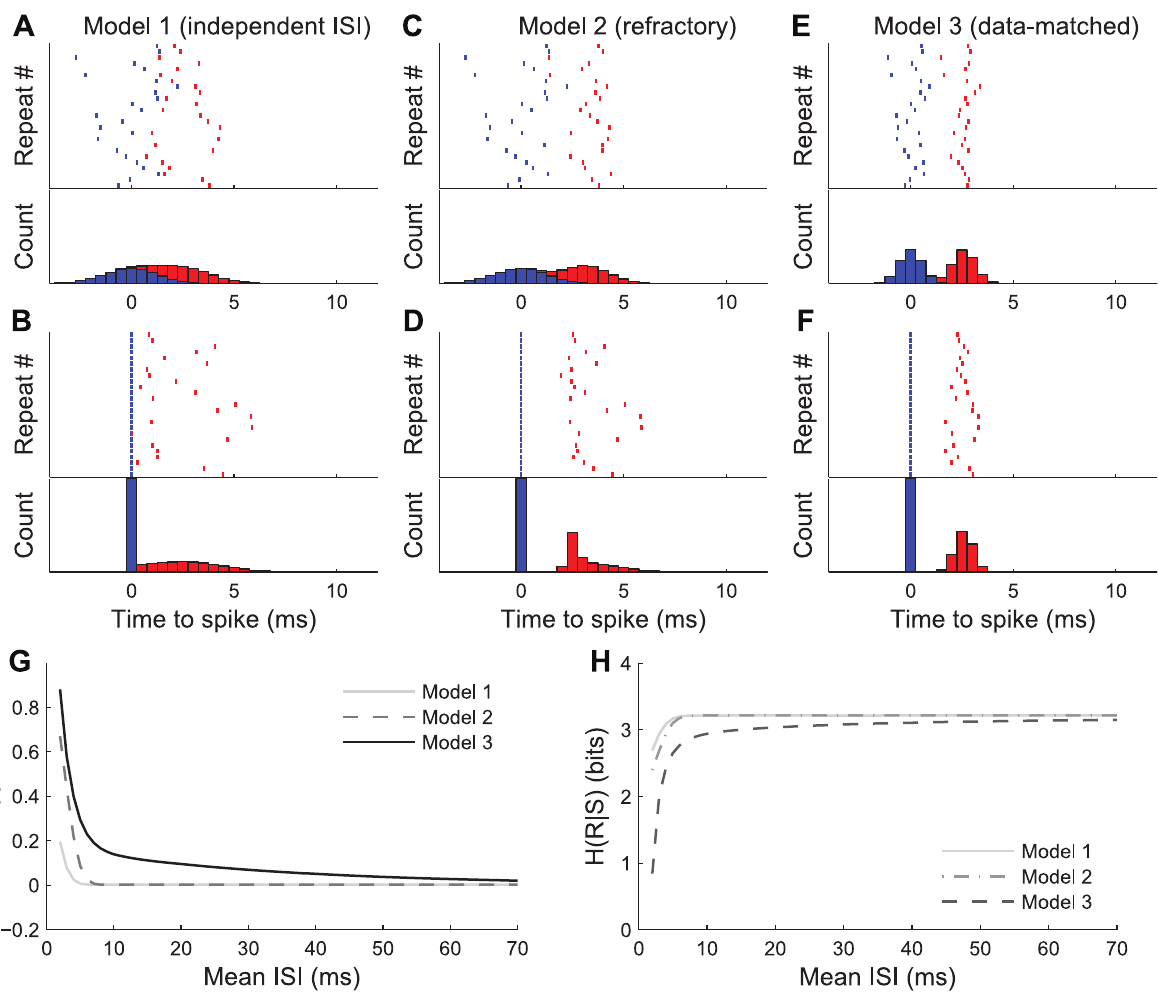
Figure 3. Three models of spike-spike interactions in doublet patterns. A, Upper trace: raster plot of response from cell model 1 (independent ISI) to repeated presentations of a stimulus which reliably elicits a doublet with mean ISI of 2.6 ms, plotting convention as in Figure 2A. Both the first (blue) and second (red) spikes in the doublet are drawn independently from normal distributions with means of 0 and 2.6 ms, respectively, and standard deviations of 1.3 ms. A, Lower trace: Standard PSTH of raster from upper trace, convention conserved from Figure 2. B, Upper and lower traces: raster plot and PSTH showing same data from A with each row aligned to the time of occurrence of the first spike in the response, as in Figure 2B. C and D: (data presentation as in A and B) Model 2 of doublet behavior enforcing a relative refractory period between nearby spikes, using recovery function from Figure 1C and jitter SD of 1.3 ms. E and F: Model 3 (data-matched) of doublet behavior, where the relative timing of spikes is determined by Eqs. 1 and 2. G: Correlation coefficient between timing of first and second spikes of doublets drawn from the three models as a function of ISI. Note that the correlation of Model 3 matches the exponential model from Figure 2F by design. H: Conditional entropy (Eq. 4) of response pattern as a function of mean ISI for all three models.